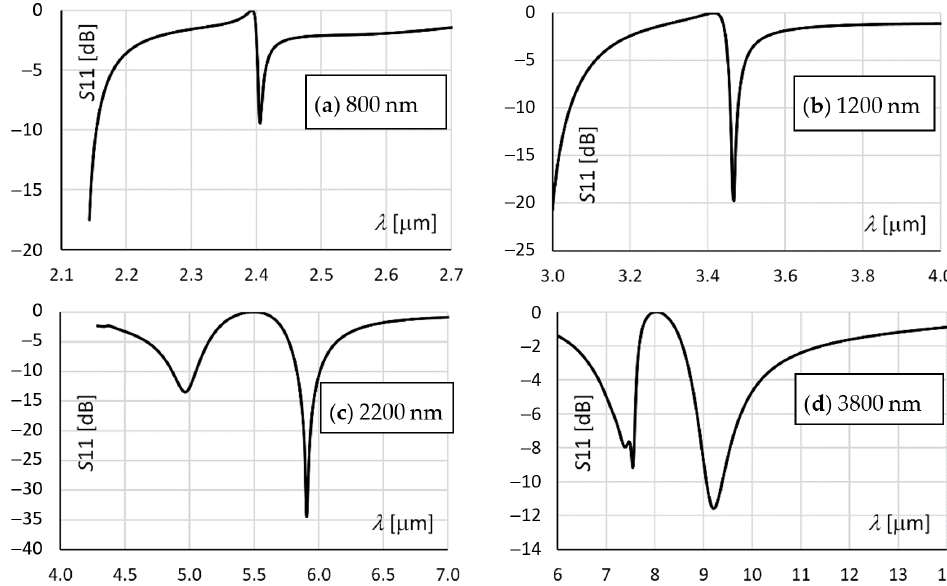
Figure 2. Results of numerical analysis of the reflectance of complementary dipole structures with lengths of ( a ) 800 nm; ( b ) 1200 nm; ( c ) 2200 nm; ( d ) 3800 nm.